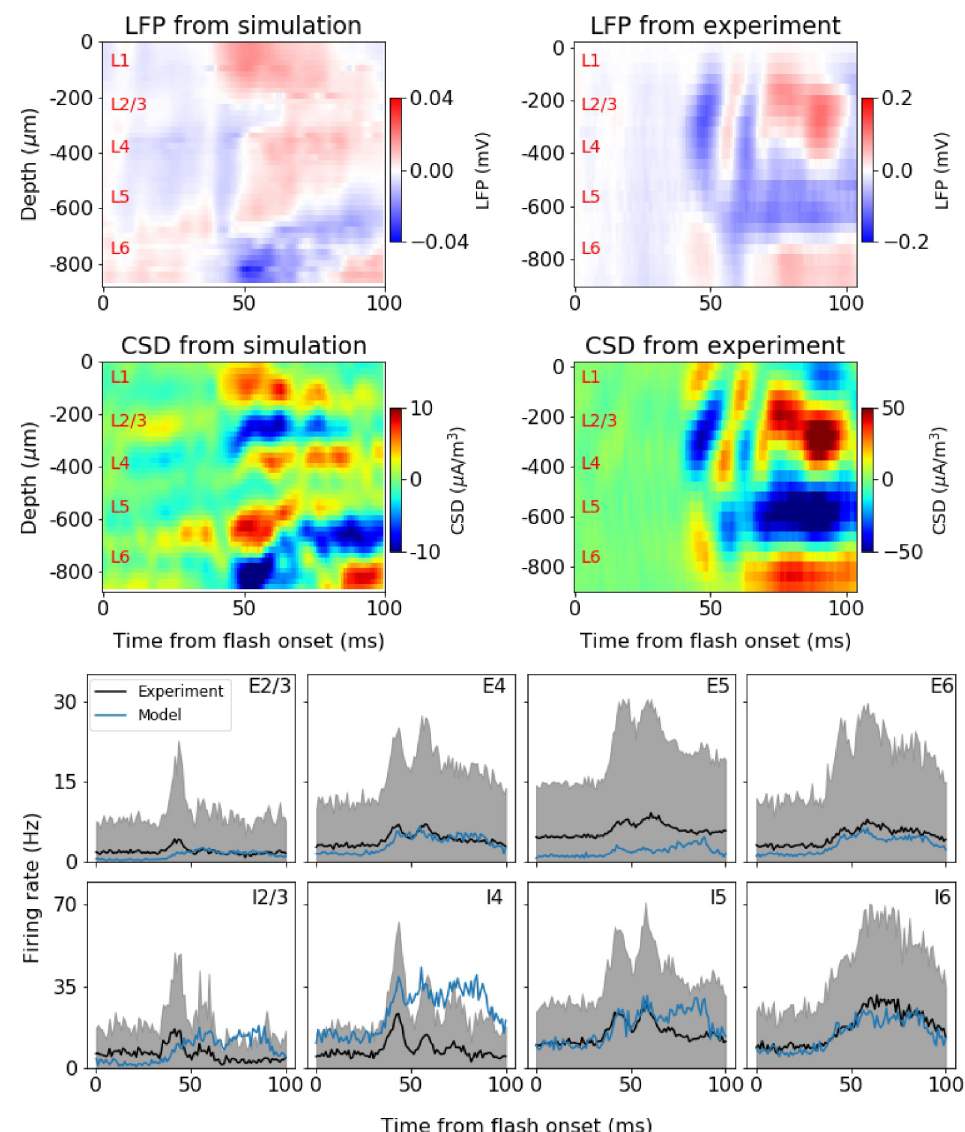
Fig 7. Computing extracellular field potential in BMTK. A simulation using a version of the V1 model ( Fig 6 ) with a white full-field flash stimulus is illustrated. The BioNet module of BMTK was used to run the simulation and compute the extracellular potential at multiple virtual electrode locations along the cortical depth; consequently, the potential was used to obtain the Local Field Potential and Current Source Density (CSD). Top row: LFP from example simulation and example mouse. The LFPs are found from averaging over 5 trials in the simulation and 75 trials in the experiments. Middle row: Corresponding CSDs for the LFPs in top row. The CSD is estimated using the delta-source iCSD method [51] assuming a column diameter of 0.8 mm for the simulation (the diameter of the core with biophysically detailed neurons in the model) and 1.6 mm for the experiment (roughly in accordance with the diameter of mouse V1). Bottom row: firing rates for the excitatory (“E”) and inhibitory (“I”) populations in each layer (2/3, 4, 5, and 6). Black: experiment mean. Gray: experiment standard deviation. Blue: simulation mean. Simulation rates are averaged over all neurons in a population and 5 trials. Experimental data are averaged over all neurons of the given type recorded from 47 mice, 75 trials each.